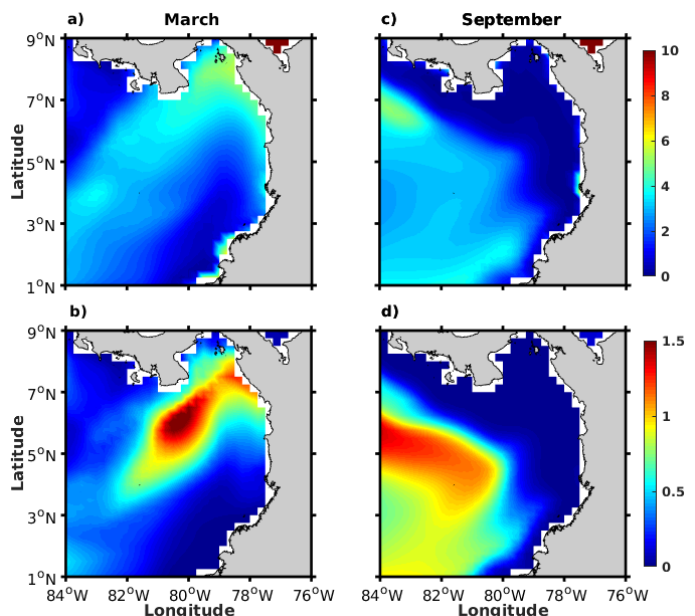
Figure 10. Spatial distribution of the nitrate / phosphate and nitrate / silicate ratios (in color scale) in the PB for ( a , b ) March and ( c , d ) September. In the case of the nitrate / phosphate ratio (a and c), the red color indicates deficit of nitrate, whereas in the case of the nitrate / silicate ratio (b and d), the red color indicates deficit of silicate.